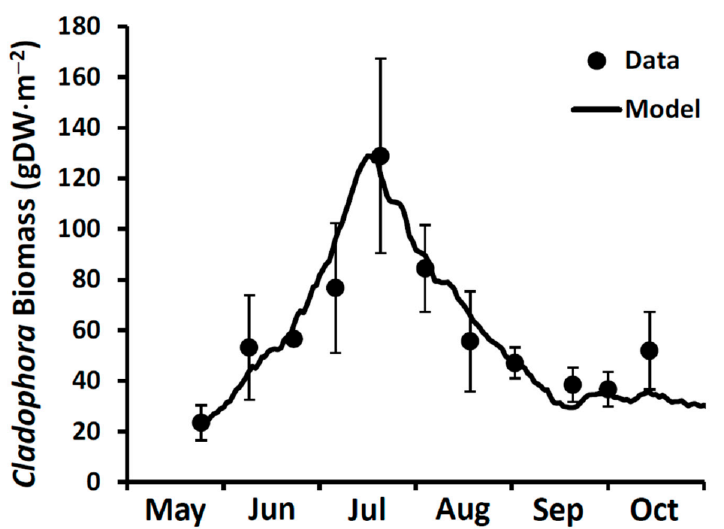
Figure 7. GLCMv3 model fit to field measurements made at a depth of 6m at the Lake Ontario study site in 2020. Dots are the mean of triplicate measurements and bars represent the standard deviation for those means for each sampling date. Data used with permission of Ontario Power Generation,